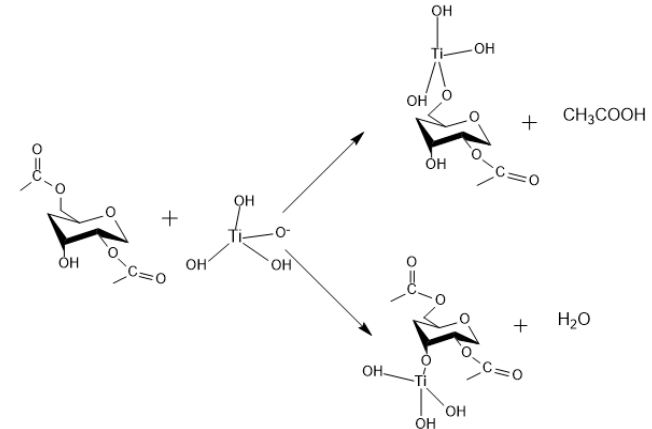
Membranes 2020 , 10 , x FOR PEER REVIEW Figure A6. Hetero-condensation between Si(OH) 4 and CA polymer molecules. Figure A6. Hetero-condensation between Si(OH) 4 and CA polymer molecules.